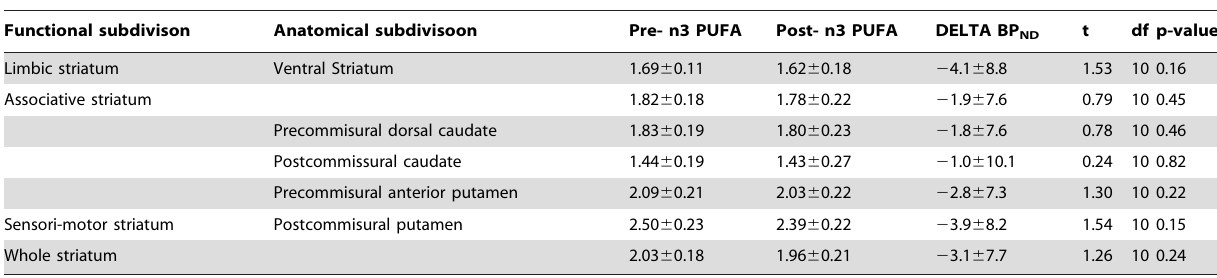
Table 4. Regional [ 11 C]DTBZ binding potential (BP ND